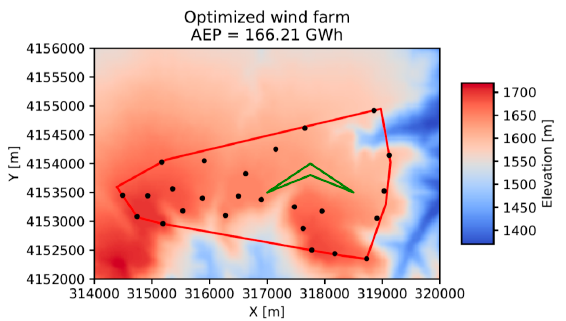
Figure 9. Best optimized design found by the framework with E max = 10,000 , M max = 5000 To better compare the performance of the original, initial, and optimized designs as shown in